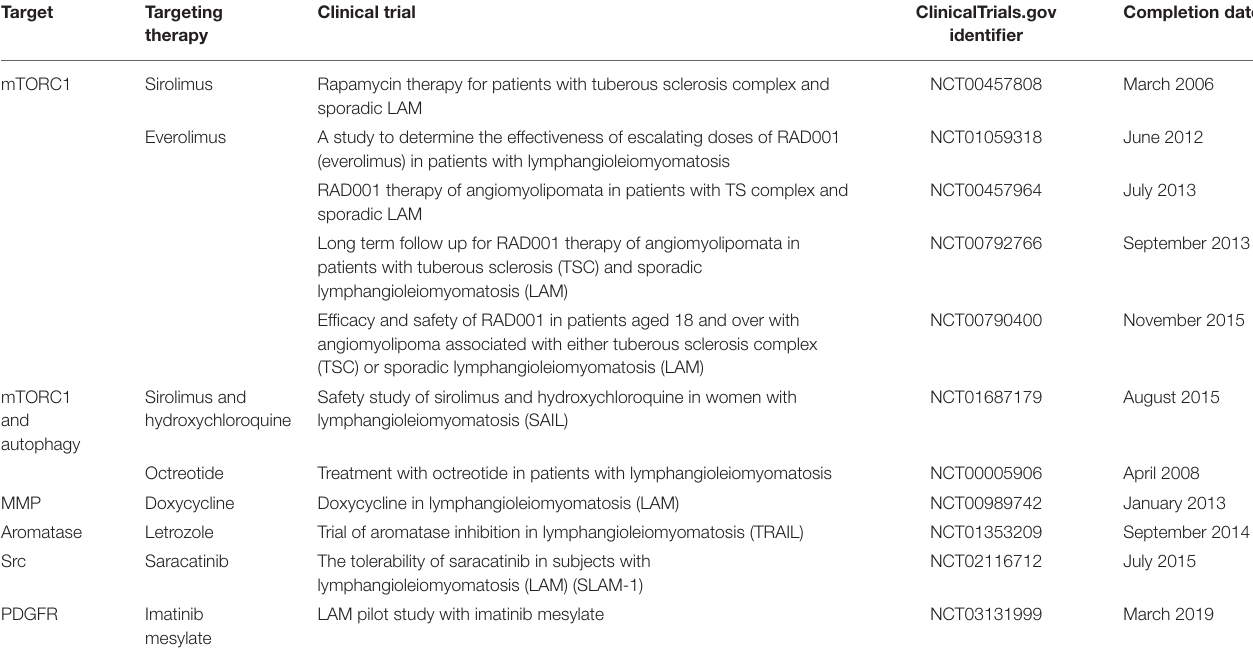
TABLE 2 | Completed clinical trials studying therapeutic targets for